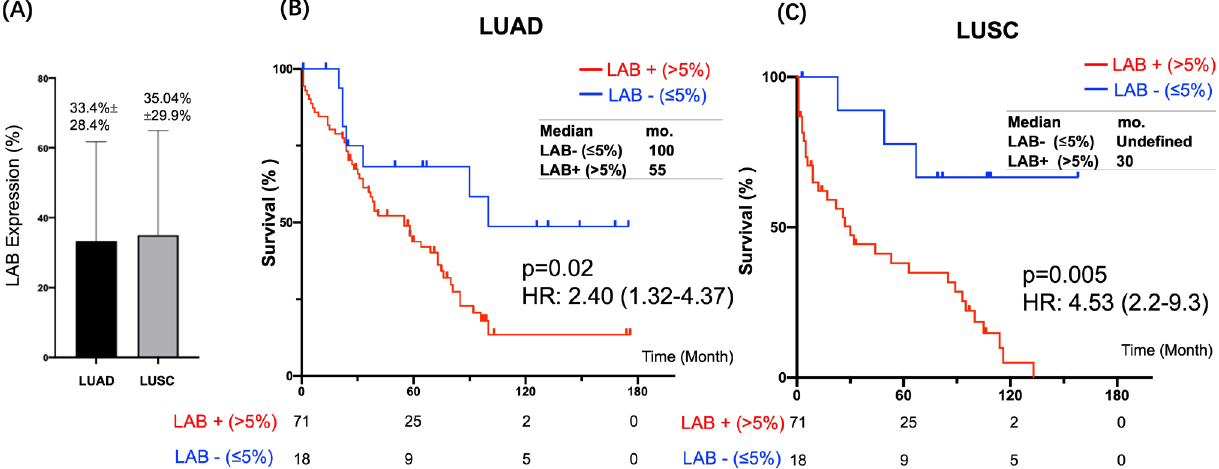
Figure 5. LAB expression in histology subtypes of NSCLC. ( A ) The median LAB expression was